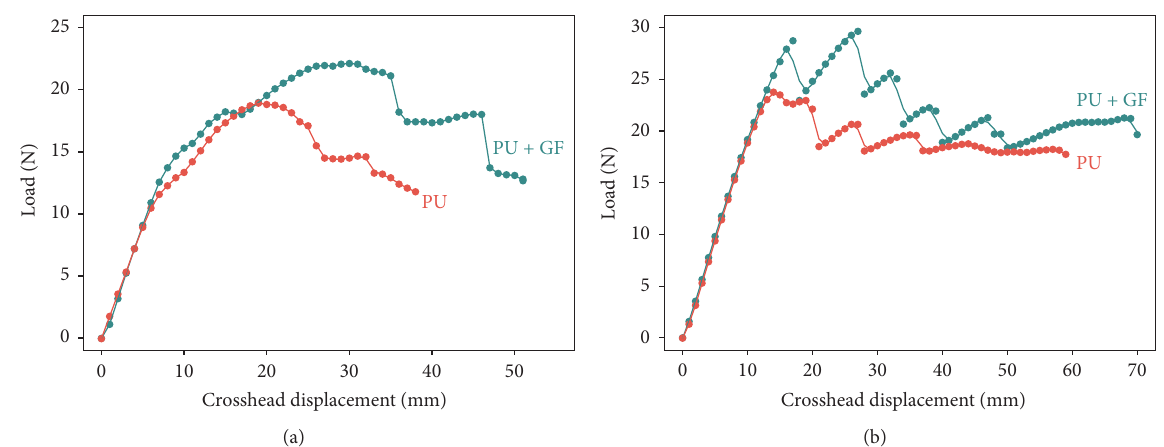
Figure 7: Load-displacement curves of specimens with unmodified polyurethane (PU) adhesive or adhesive modified by the addition of 5.5% w/w glass fibre (GF): (a) No through-reinforcement; (b) through-reinforcement (24 reinforcements).